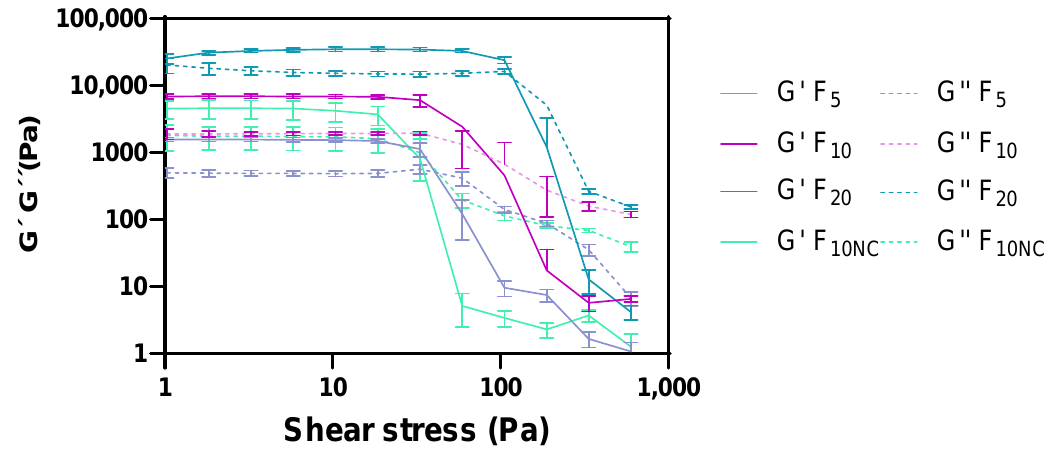
Figure 4. Effect of glycerol monostearate content (F 5 , F 10 and F 20 ) and homogenization rate (F 10NC ) on the formulation amplitude sweep.